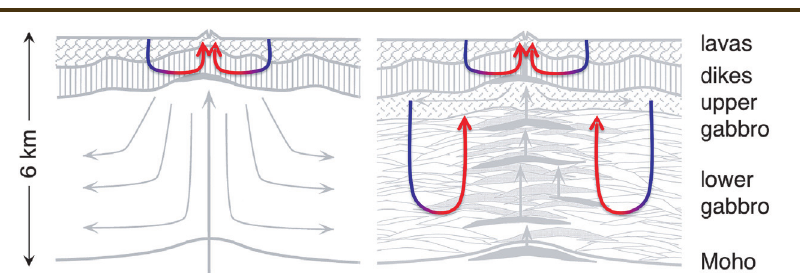
Figure 4. Crystallization of gabbros in a shallow melt lens requires rapid removal of heat by hydrothermal convection in the upper crust. Crystallization of gabbros at a range of depths requires hydrothermal circulation down to the base of the crust. Measurement of mineral zoning in Oman gabbros, interpreted in terms of cooling rates, will resolve which was